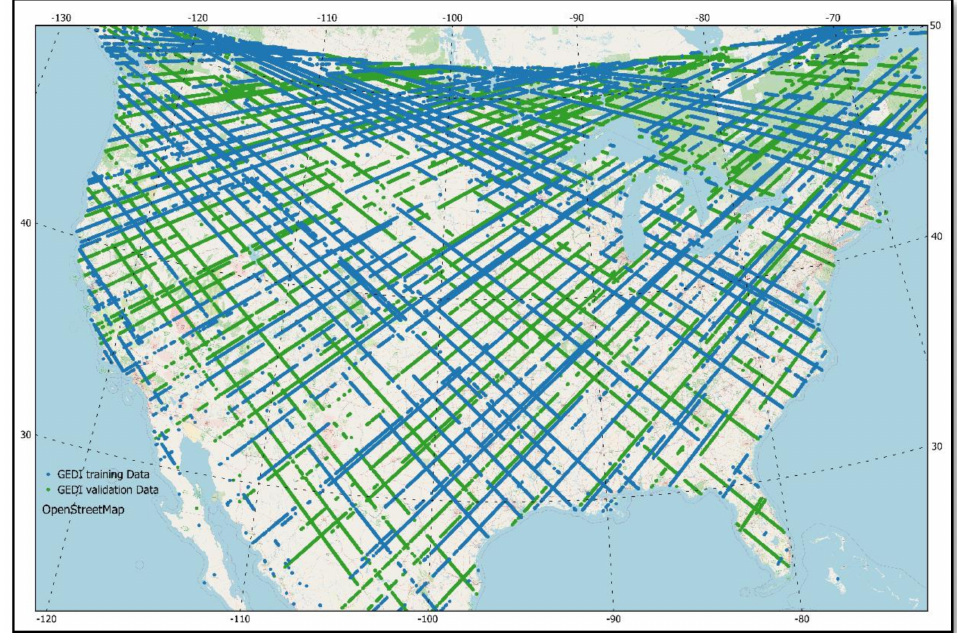
Figure 1. The spatial distribution of Global Ecosystem Dynamics Investigation (GEDI)-VIIRS paired data for model calibration (blue tracks) and model validation (green